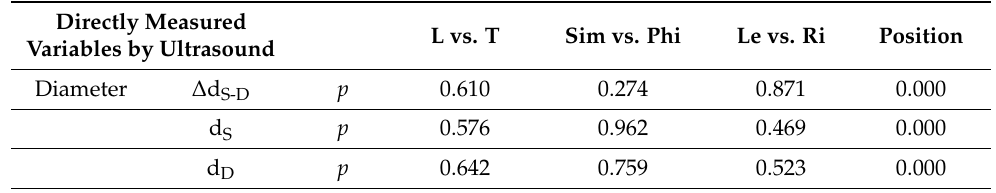
Table 1. Output of the complete factorial examination plan on ten subjects with 219 data points, the relevant parameters, test of main effects (interactions), and significances ( p